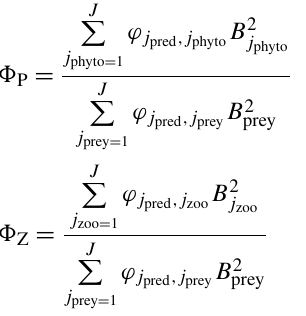
Figure A1. Zooplankton grazing on one prey with and without the prey refuge term included. Prey refuge = and Poulet, 1978). Grazing without prey refuge: G = G max · γ T · F . Grazing with prey refuge included: G = G max · γ T · F + K j pred F · Prey refuge. Temperature limitation ( γ T ), prey palatabil- F + K j pred ity ( ϕ ) and prey refuge constant ( (cid:51) ) equal to 1, and F = ϕ · B .